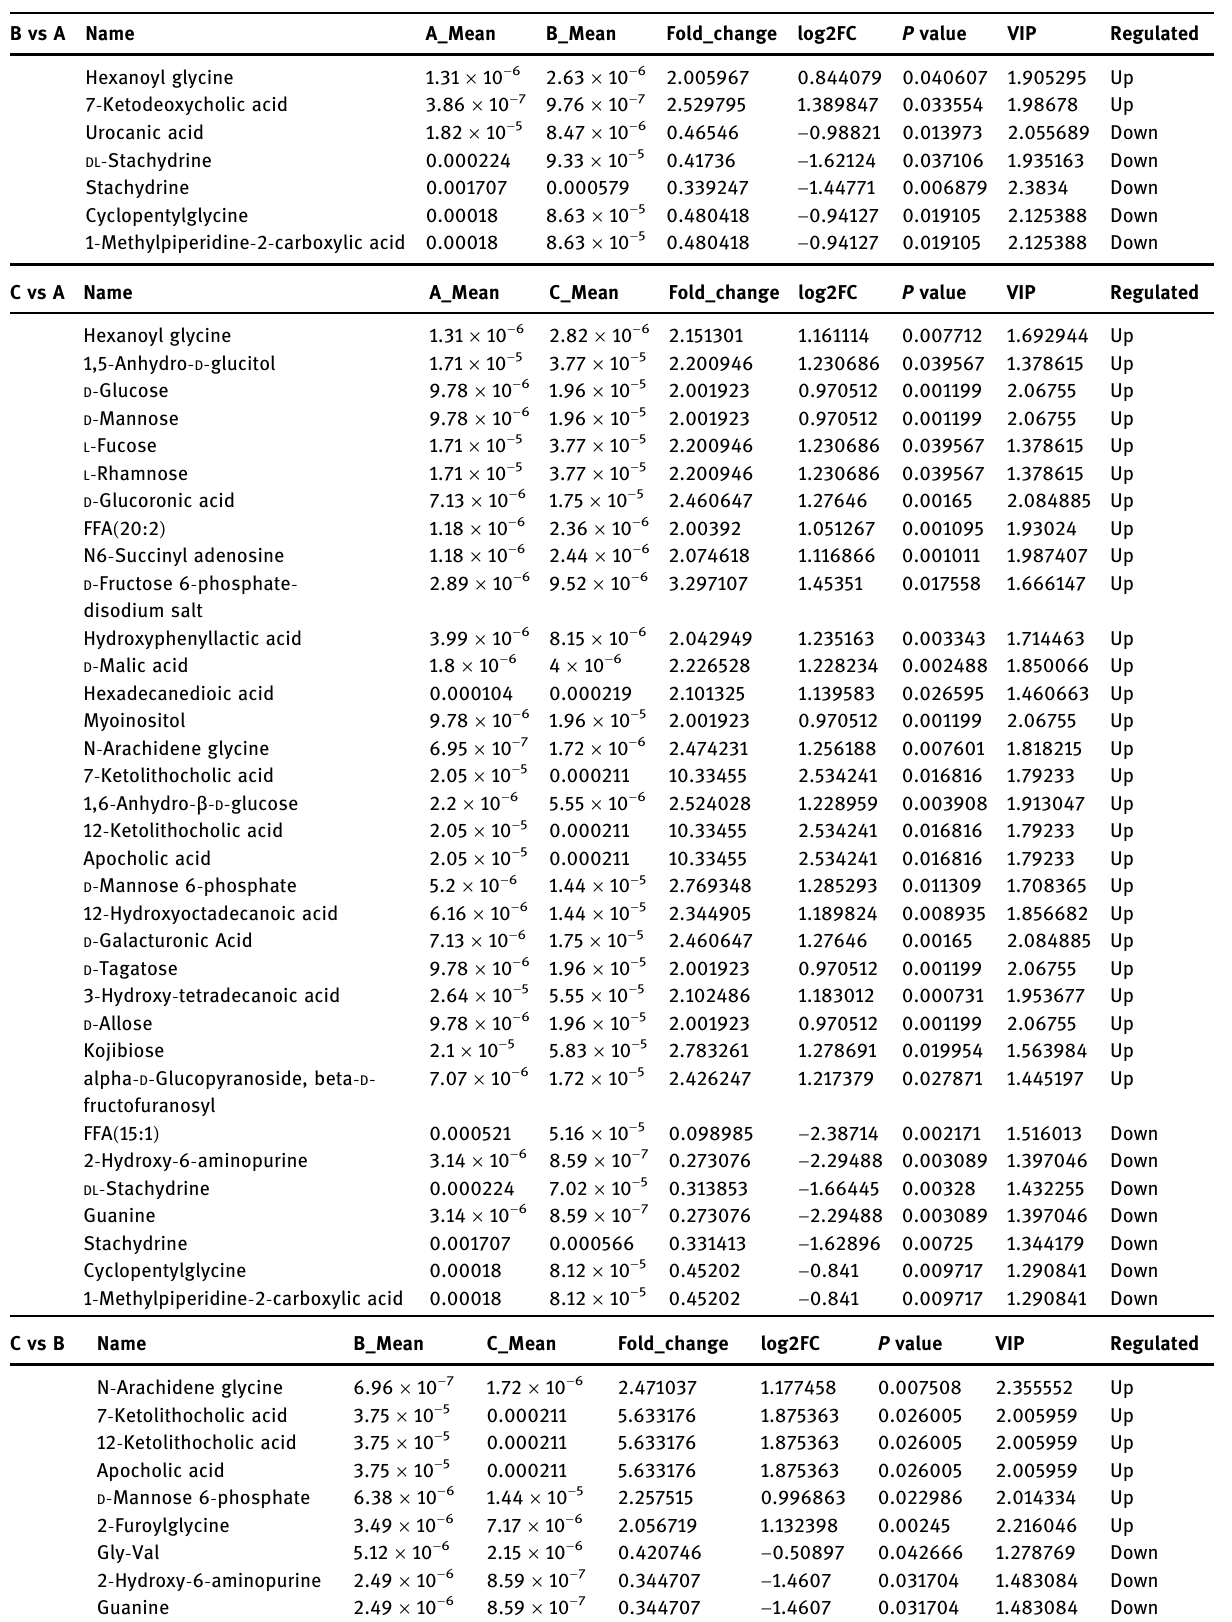
Table 3: Identi fi cation results of di ff erential metabolites in B vs A, C vs A, and C vs B groups in